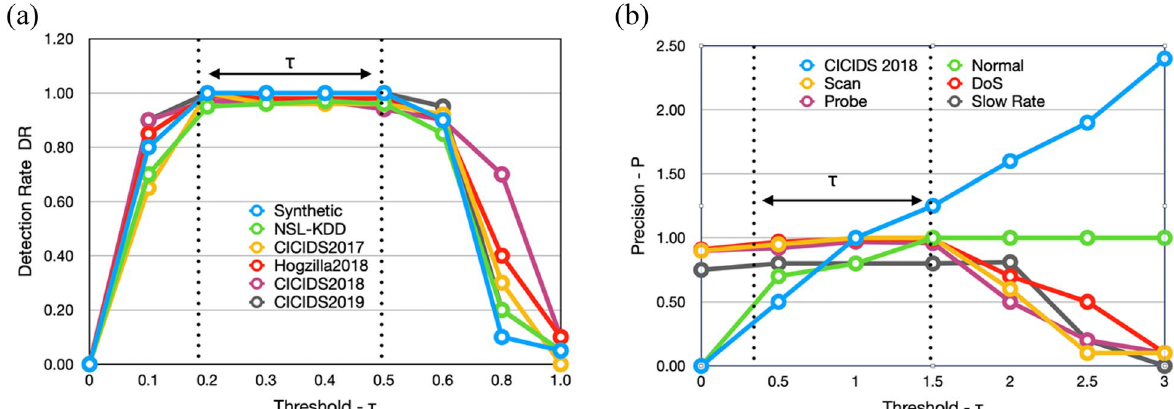
Fig. 22 For different threshold values, a Detection rate b Precision